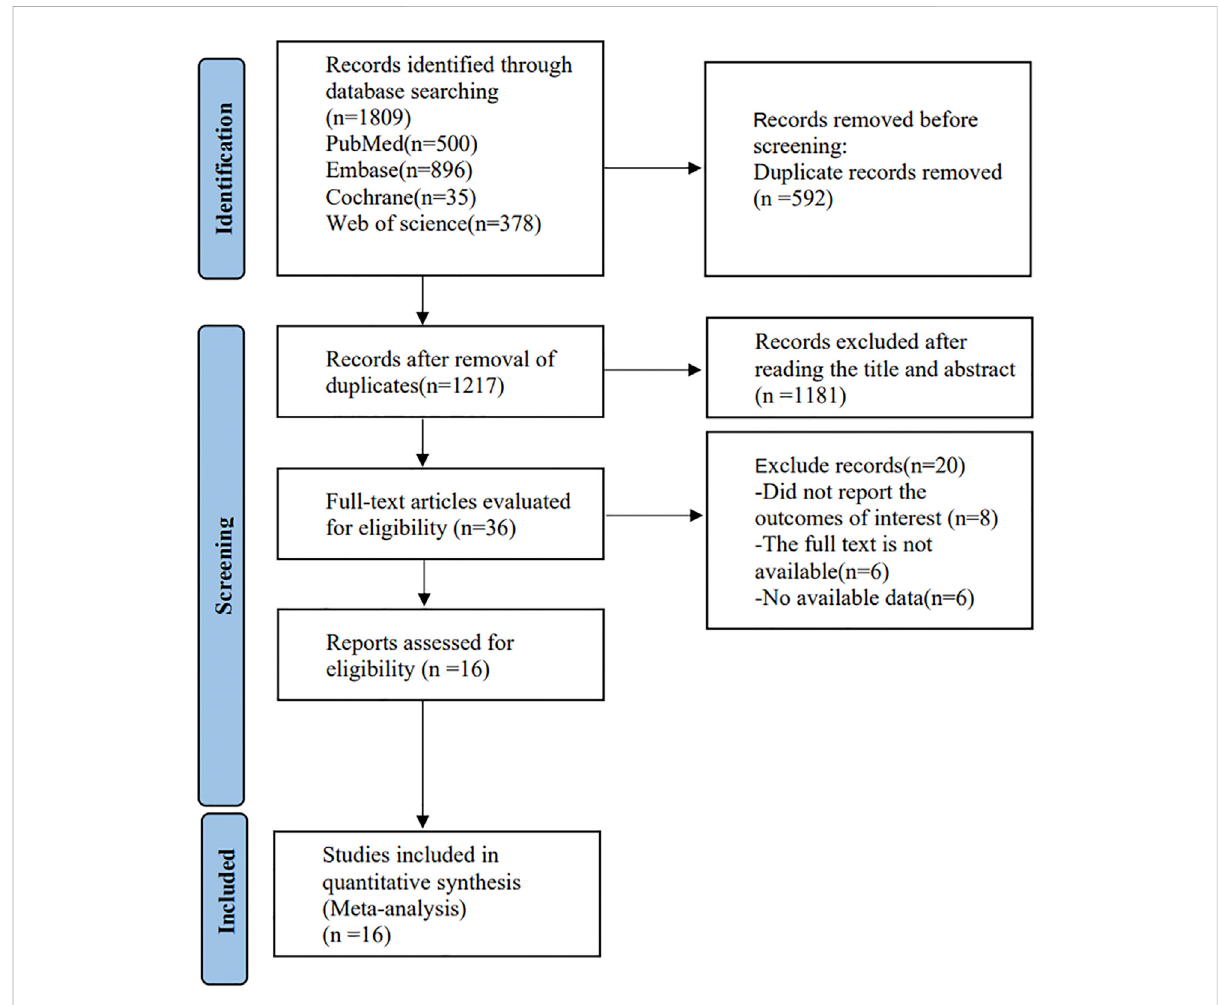
FIGURE 1 Flow chart of literature